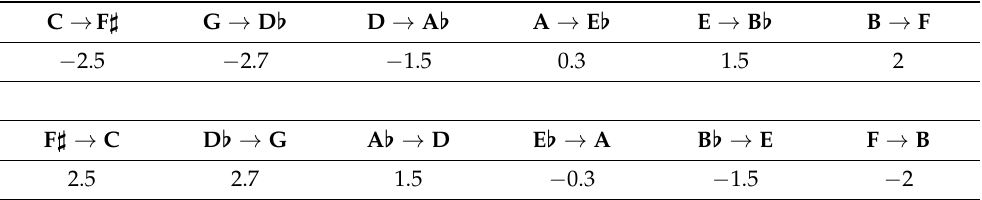
Table 1. Characteristic values [Y → Z] corresponding to the directed axes of the music signature presented in Figure